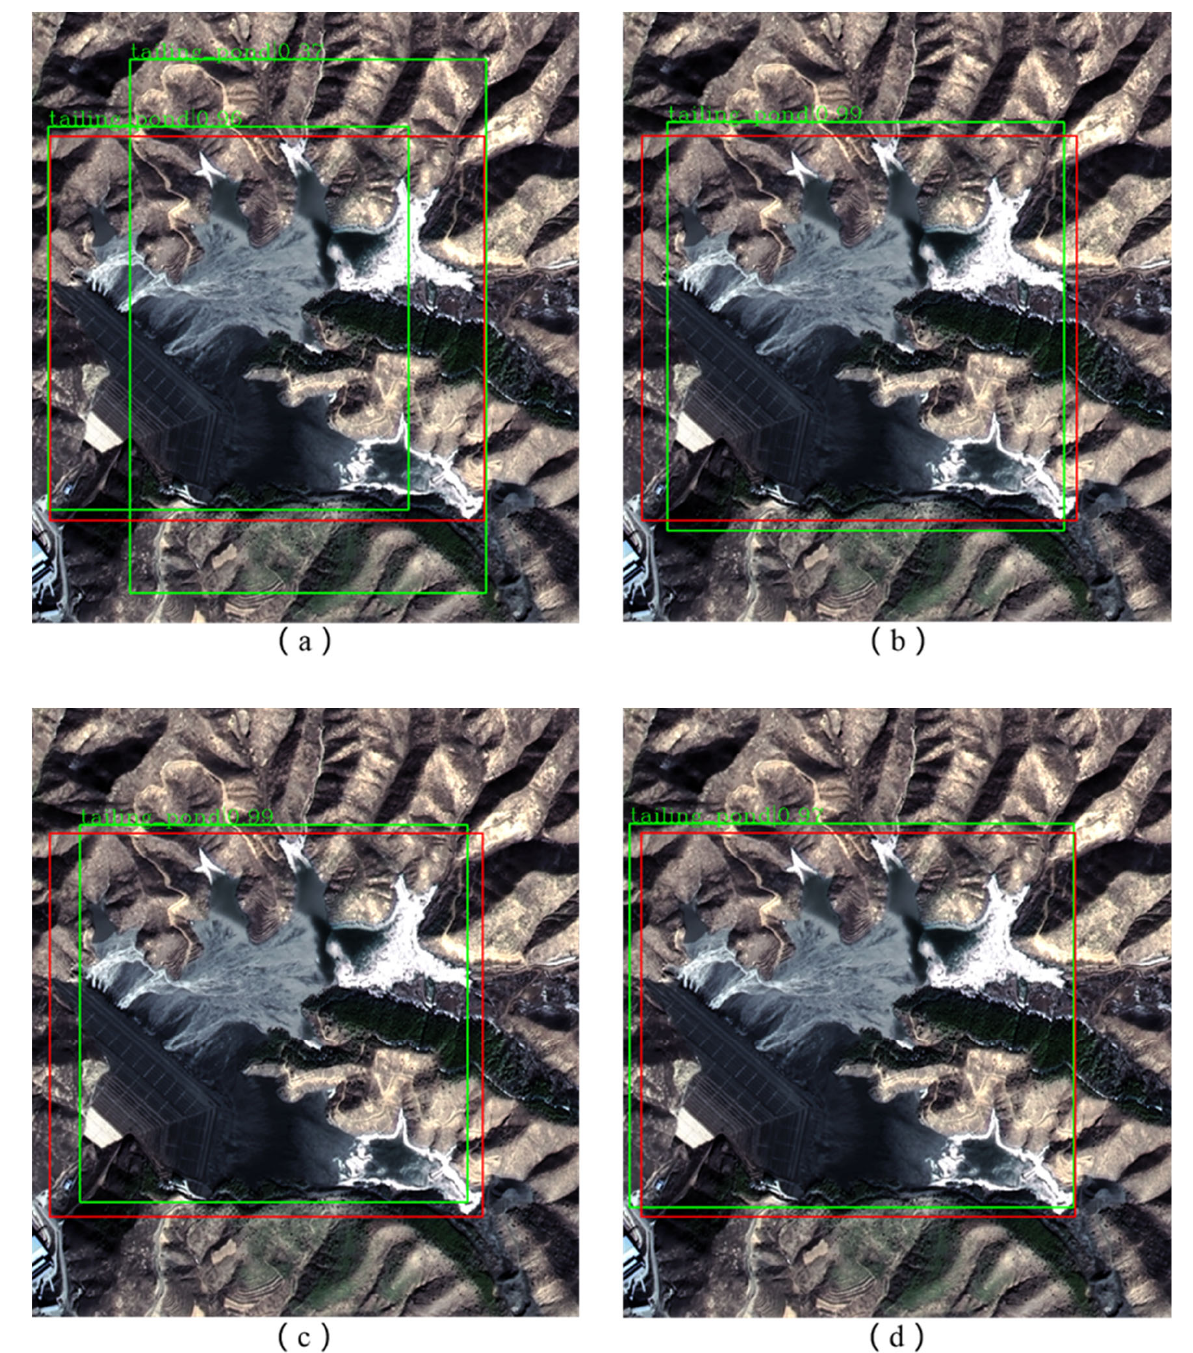
Figure 9. Improved accuracy of tailings pond detection. ( a ) prediction result of the Bands_3 model, ( b ) prediction result of the Bands_4 model, ( c ) prediction result of the Bands_4_sub model, ( d ) prediction result of the Bands_4_sub_SAMB model, the red bounding box represents the GT of the tailings pond and the green bounding box represents the PT of the tailings pond.